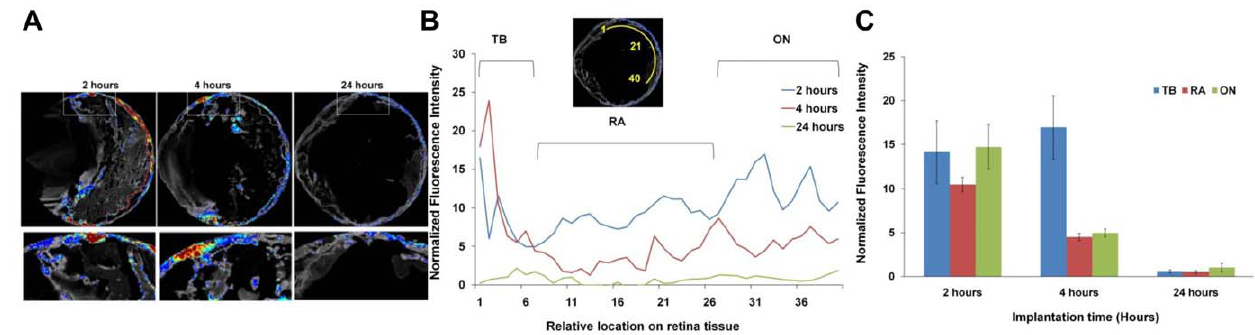
Figure 2. Distribution of FITC-labeled PNIPAM nanoparticles after intravitreous administration over a day. Localization of fluorescence in the posterior segments of the eye at various time points (2, 4 and 24 hours) was observed (A) and quantified (B). Quantification of the normalized fluorescence intensity at various locations (TB: Trabecular Meshwork; RA: Retina; ON: Optic Nerve) at various time points (C).